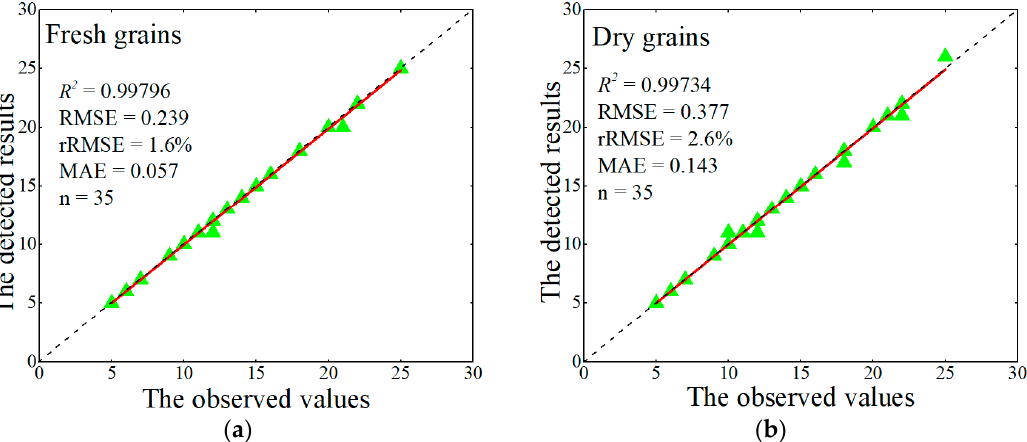
Figure 8. Comparison between the manual observation and model results for counting grains. The solid red line is regression line, the black dashed line is 1:1 line. ( a ) fresh grains; ( b ) dry grains.